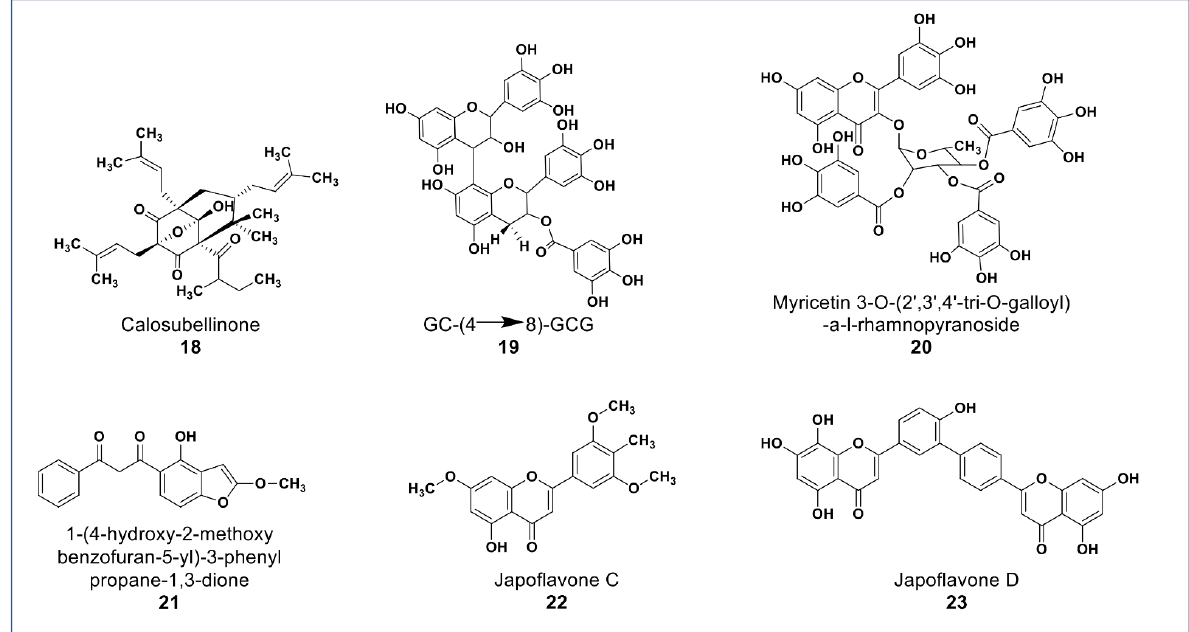
Figure 4. Representative members of new polyphenolic phytochemicals from various plant sources (compounds 18 to 23